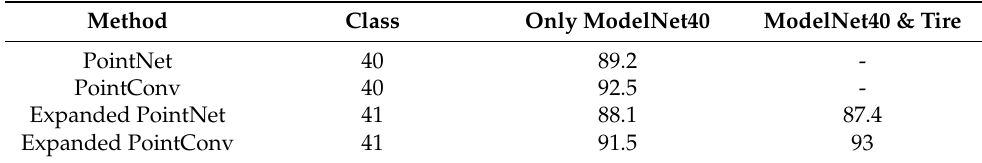
Table 4. Classification results using Modelnet40 and tire